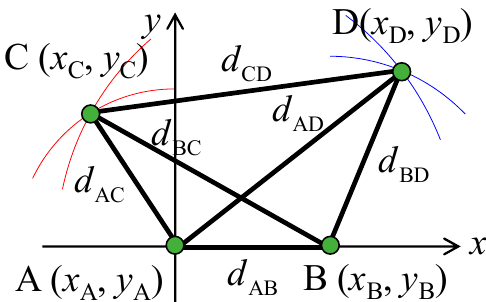
Figure 7. Arrangement of virtual point sources.